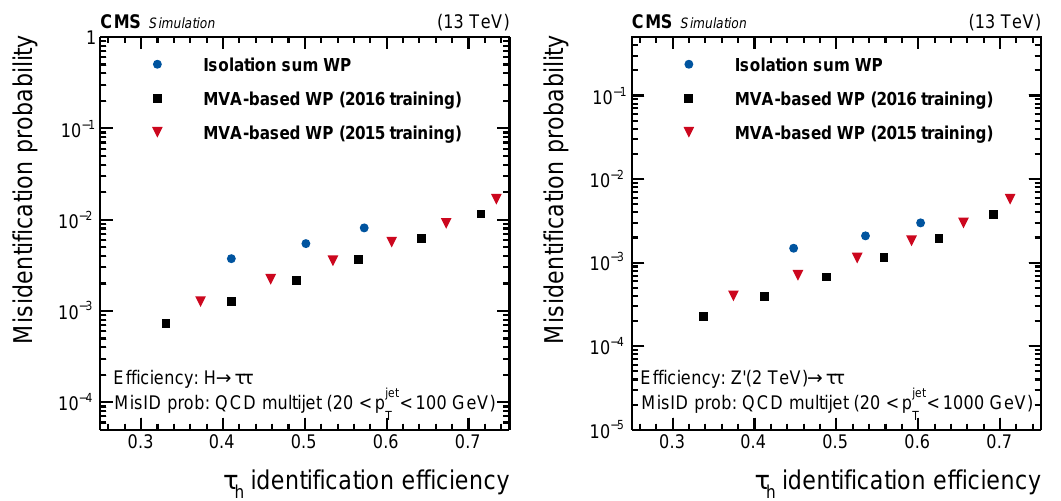
Figure 2: jet → τ misidentification probability versus the τ h for the different isolation-based and MVA-based HPS-tau working points. The result in H → ττ events is shown on the left, and that in Z (cid:48) ( 2 TeV ) → ττ events, on the right [ 1 ] .